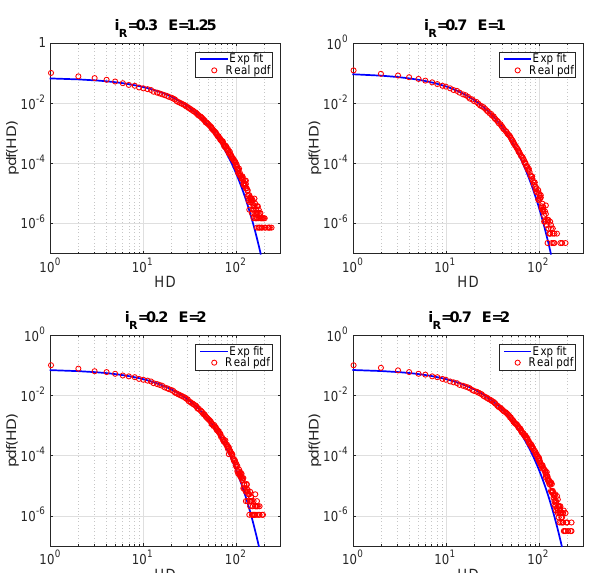
also obtained as a spatial average over the equilibrium phase for every time